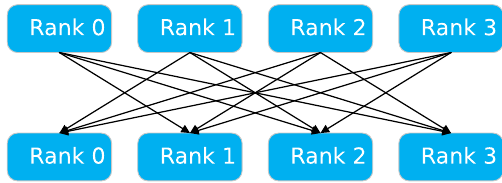
Figure 4. Pytorch distributed Allreduce method.